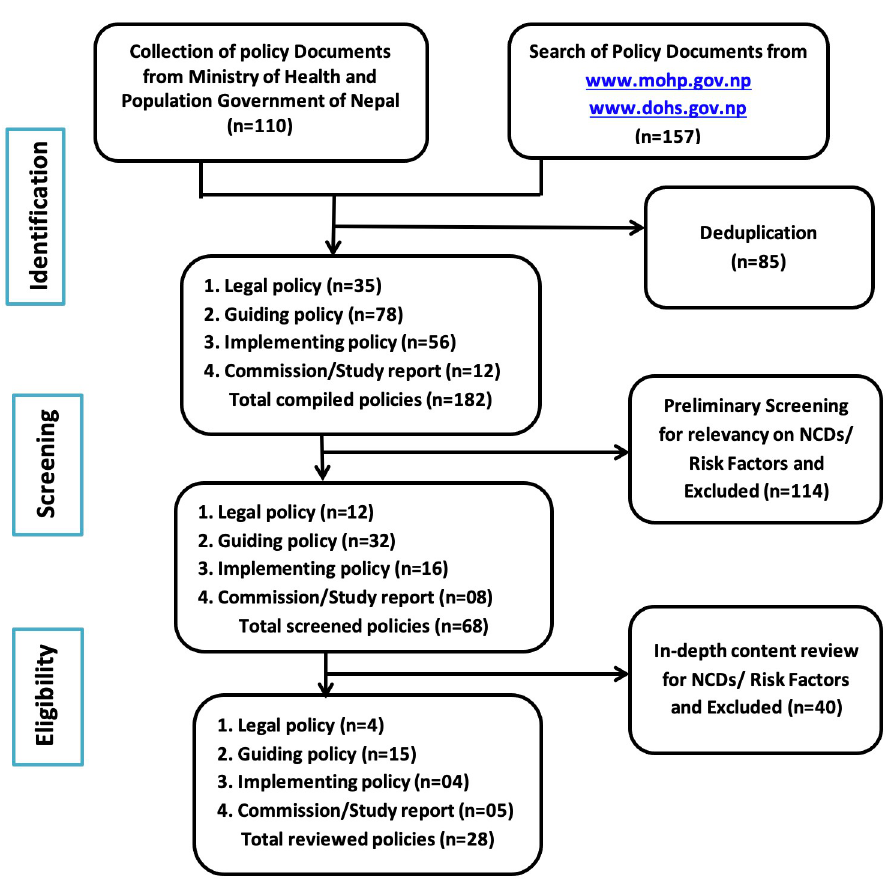
Fig 1. Strategy for screening policy